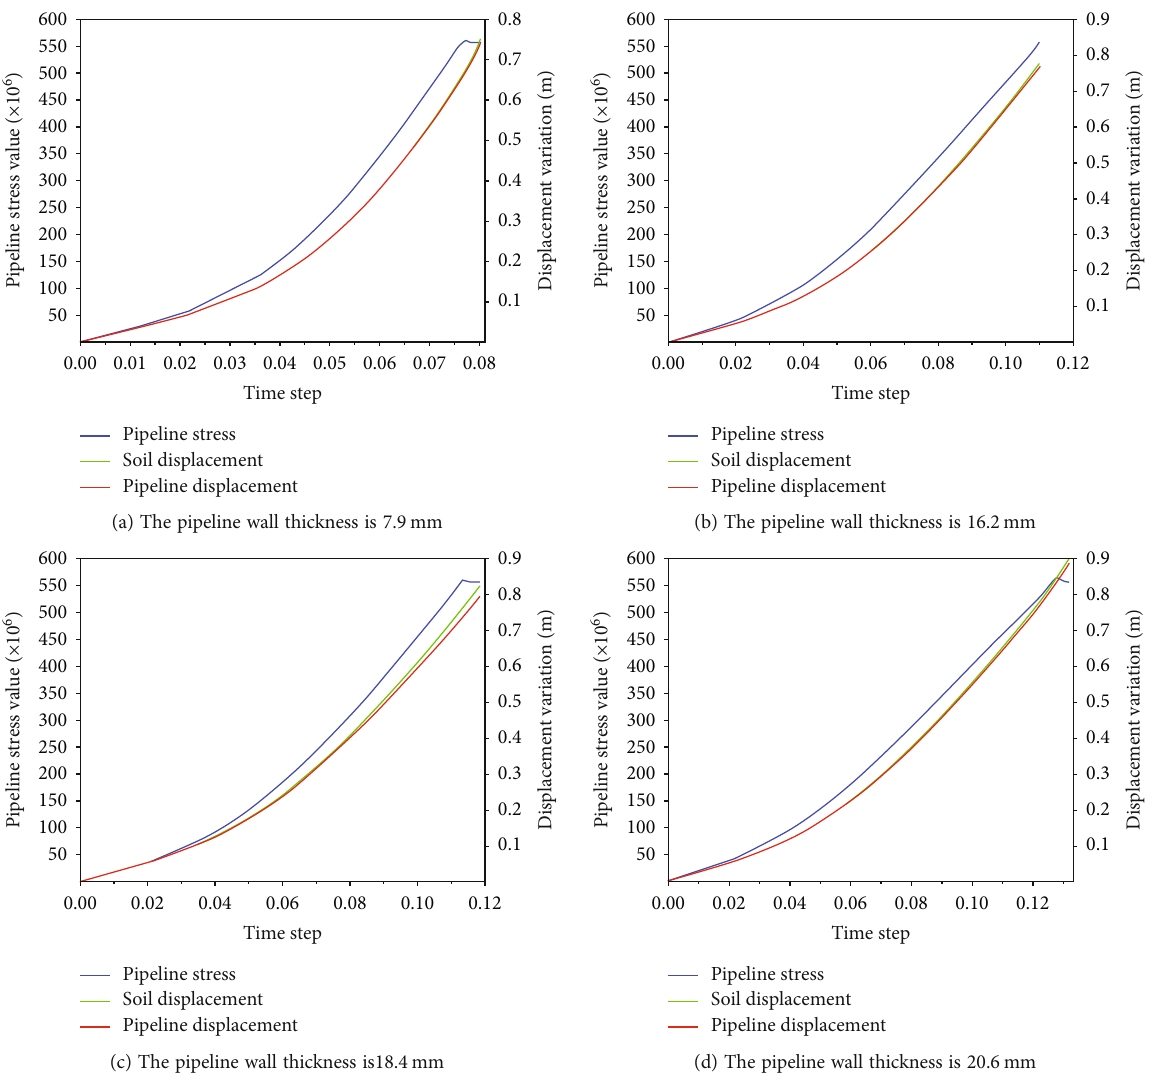
Figure 17: The diagrams of pipeline stress, displacement, and soil displacement under di ff erent pipeline wall